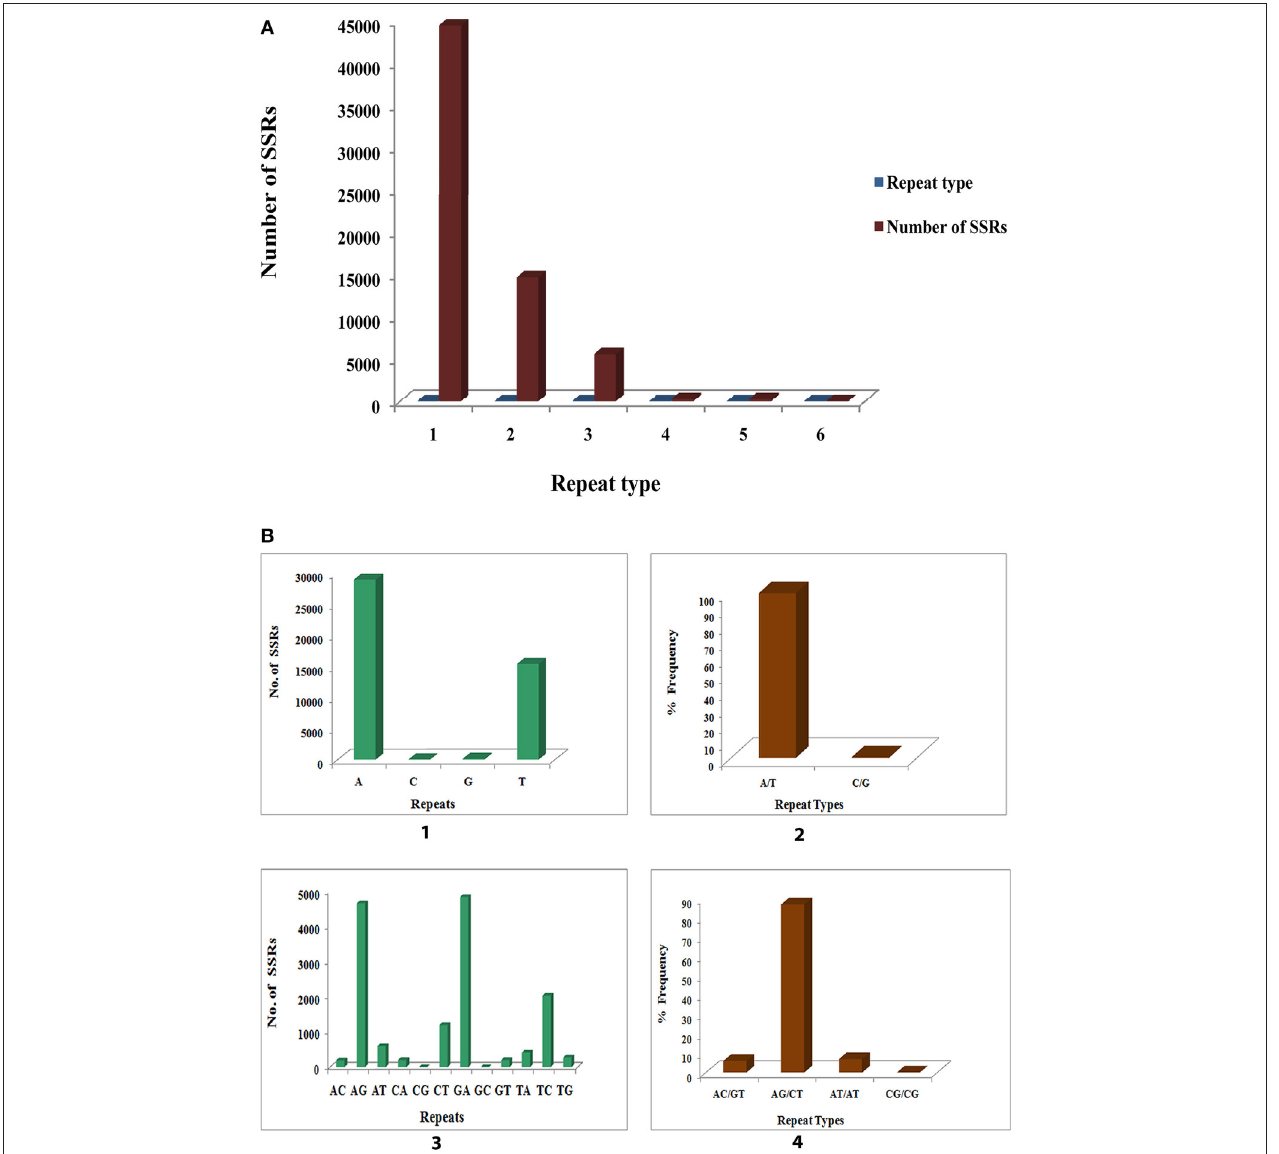
FIGURE 11 | Identification of molecular markers (SSRs) in leaf transcriptome of P. amarus . (A) Distribution of SSR’s into mono, di, tri, tetra, penta, and hexa repeat types. (B) Distribution of mono and di-nucleotide SSR motifs and percent frequency of their repeat types.